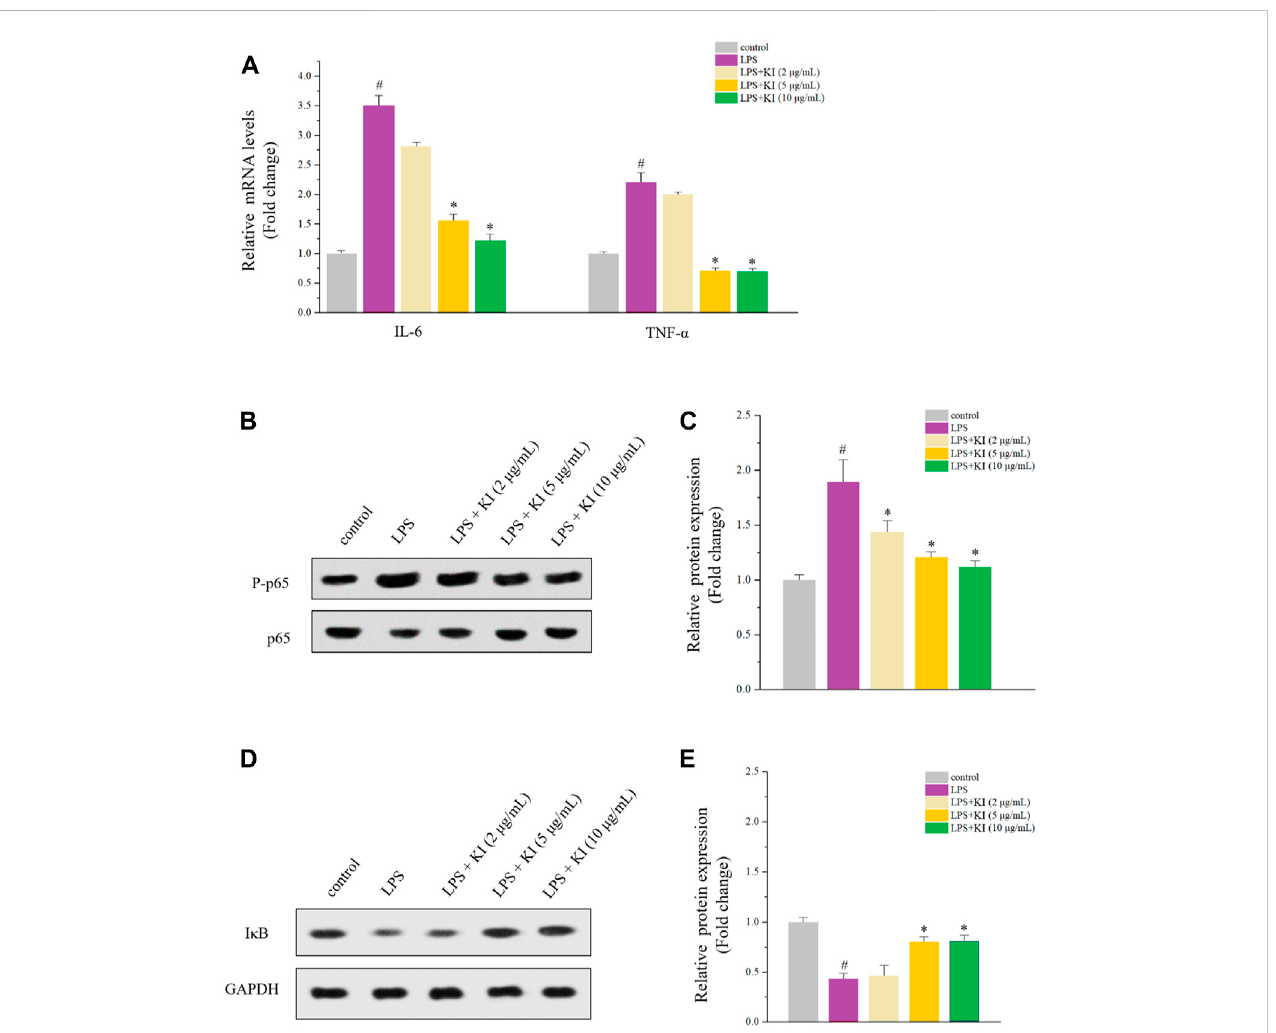
FIGURE 2 Effects ofKI on LPS-stimulatedTHP-1 cells. (A) RT-qPCR results ofIL-6 and TNF- α . PMA wasused to differentiateTHP-1 cells for 72 hand then thefresh PMA-free medium was used before the 24-h treatment of LPS or various concentrations of KI. Values are means ± SD from three separate experiments. # p < 0.05 compared with the control group; * p < 0.05 compared with LPS group. (B) Western blot results of P-p65/p65 of cells described in (A) . (C) Quantitative results of (B) . (D) Western blot results of P-p65/p65 of cells described in (A) . (E) Quantitative results of (D) . For (D) and (E) , values are means ± SD from three separate experiments. # p < 0.05 compared with the control group; * p < 0.05 compared with LPS